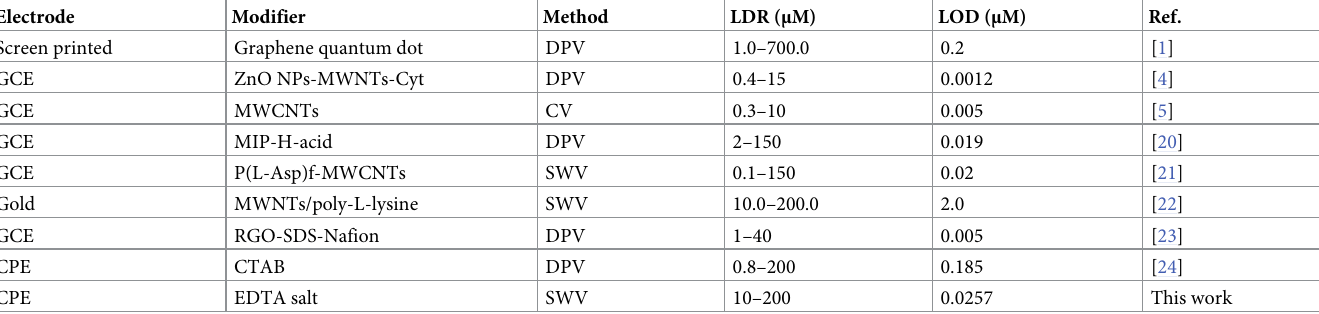
Table 3. Summary of comparison of performance of the present method with previously reported